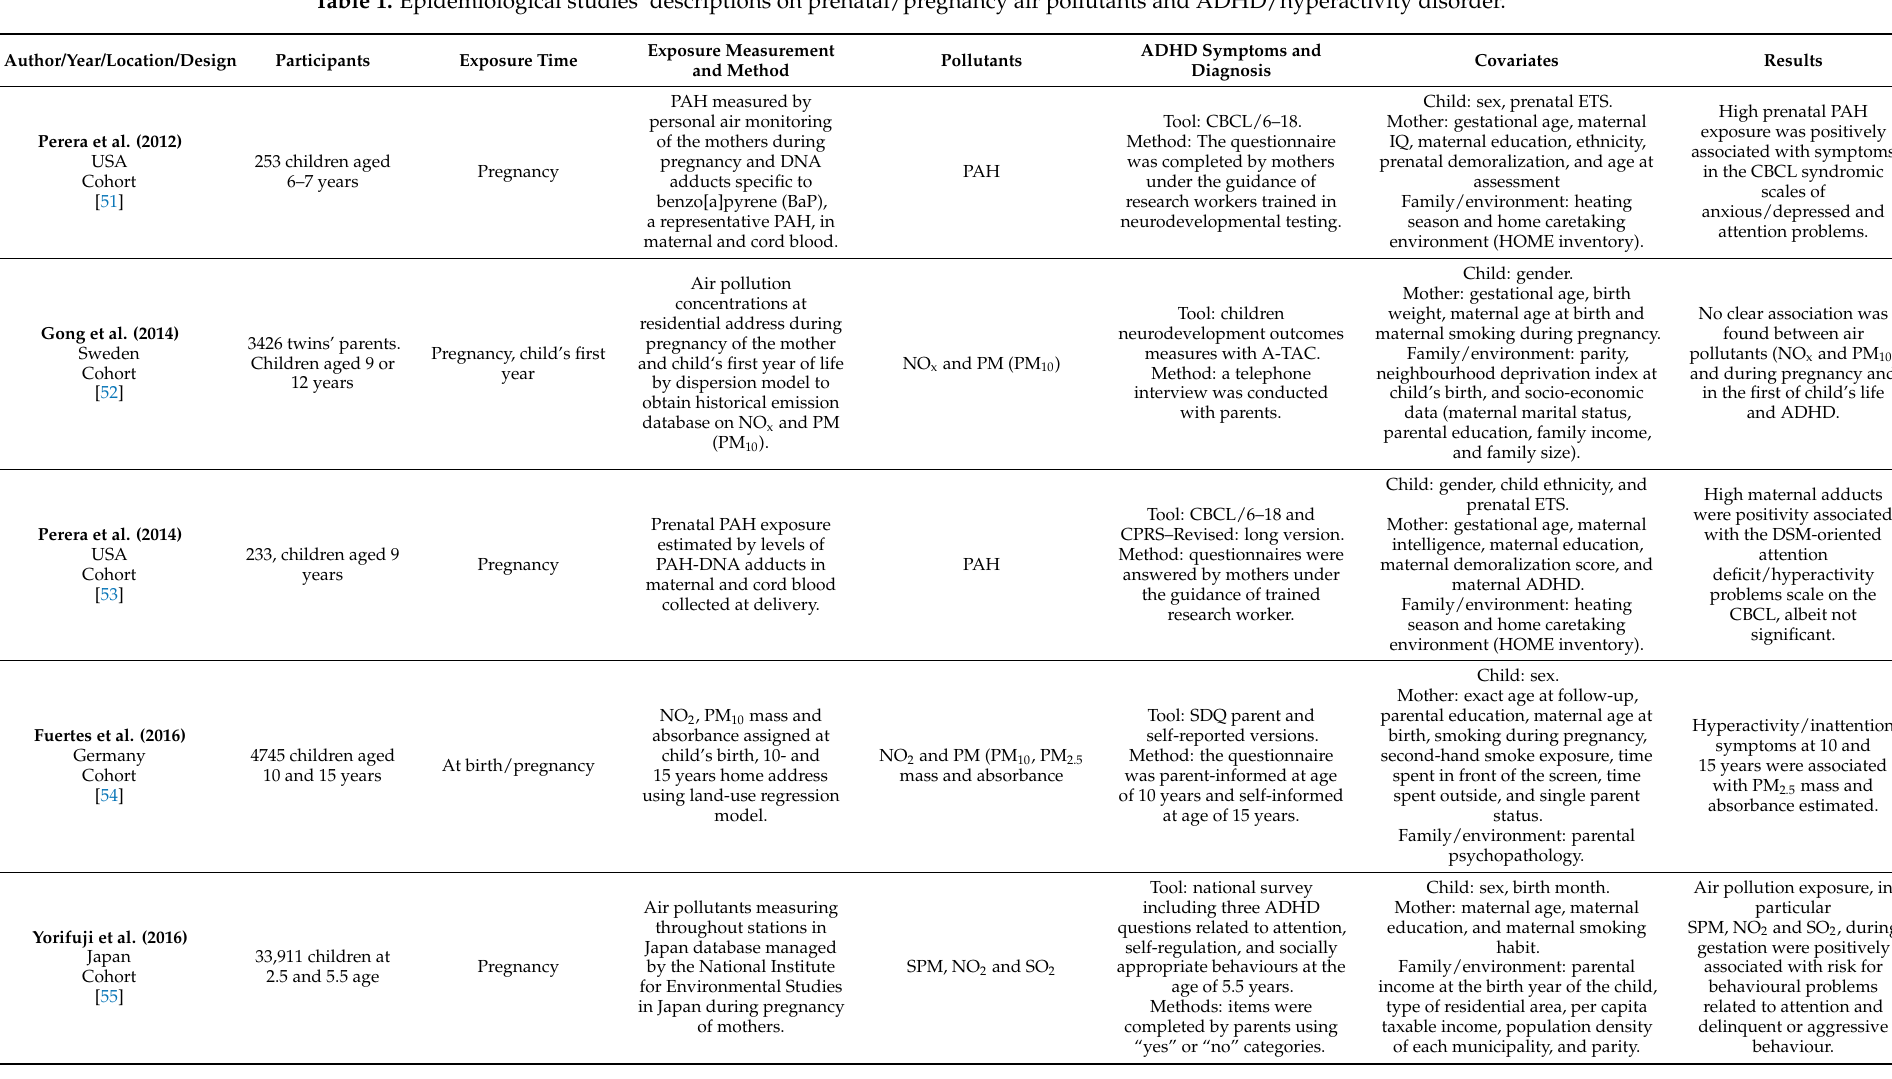
Table 1. Epidemiological studies’ descriptions on prenatal/pregnancy air pollutants and ADHD/hyperactivity